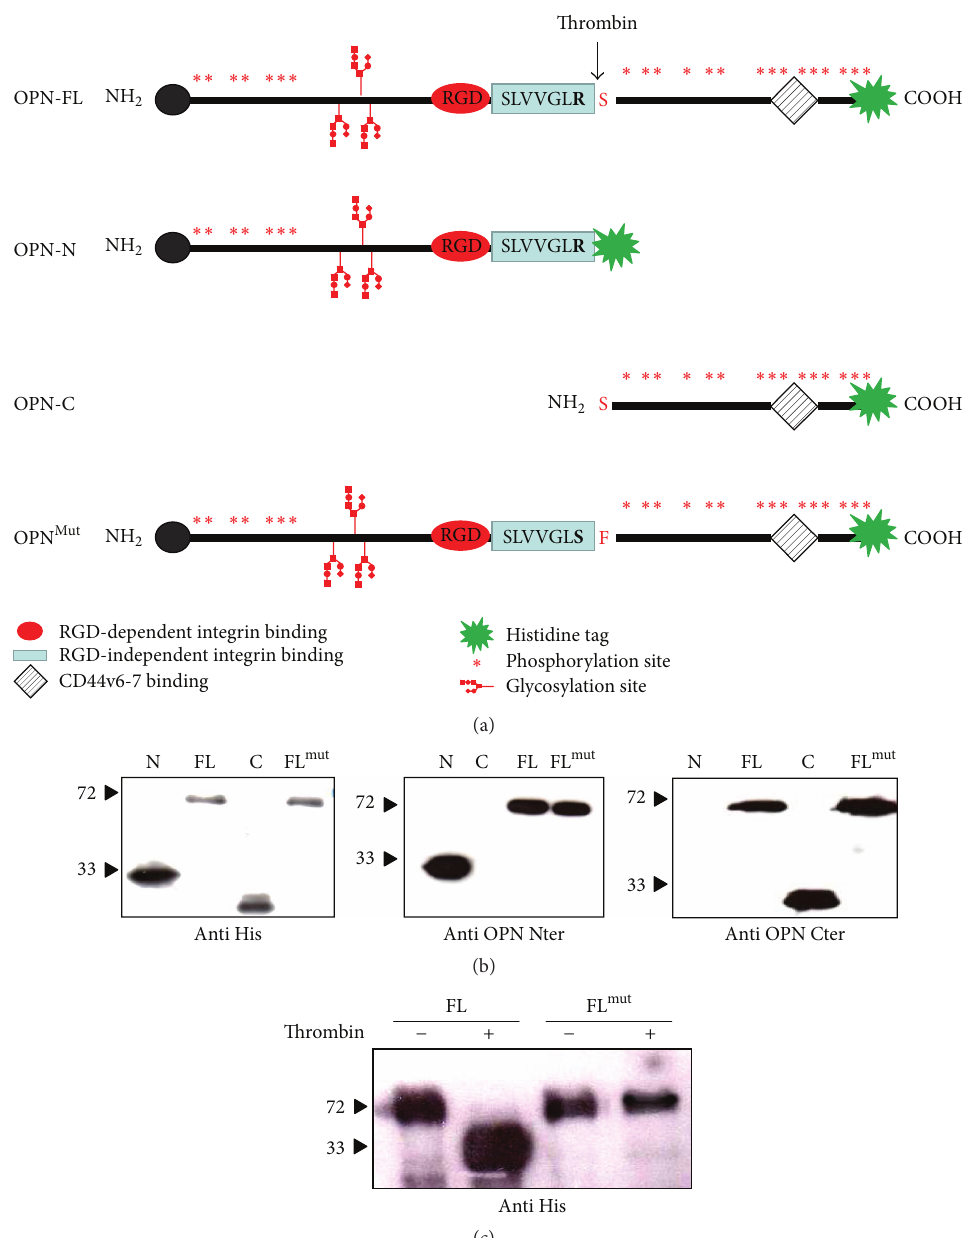
Figure 1: Recombinant OPN variants. (a) The figure depicts the recombinant OPN variants: OPN-FL (aa 17–314 human and aa 17–294 mouse), OPN-N including aa 17–168 (human) or 17–153 (mouse) of OPN; OPN-C including aa 169–314 (human) or 154–294 of OPN; mouse OPN-FL mut carrying a mutated thrombin cleavage site (from R 153 -S 154 to S 153 -F 154 ). (b) Western blotting showing the recombinant proteins after purification probed with the anti-His-tag (left panel) or antibodies specific for the N (middle panel) or C-terminal portion (right panel). (c) OPN-FL but not OPN-FL mut is cleaved by thrombin.